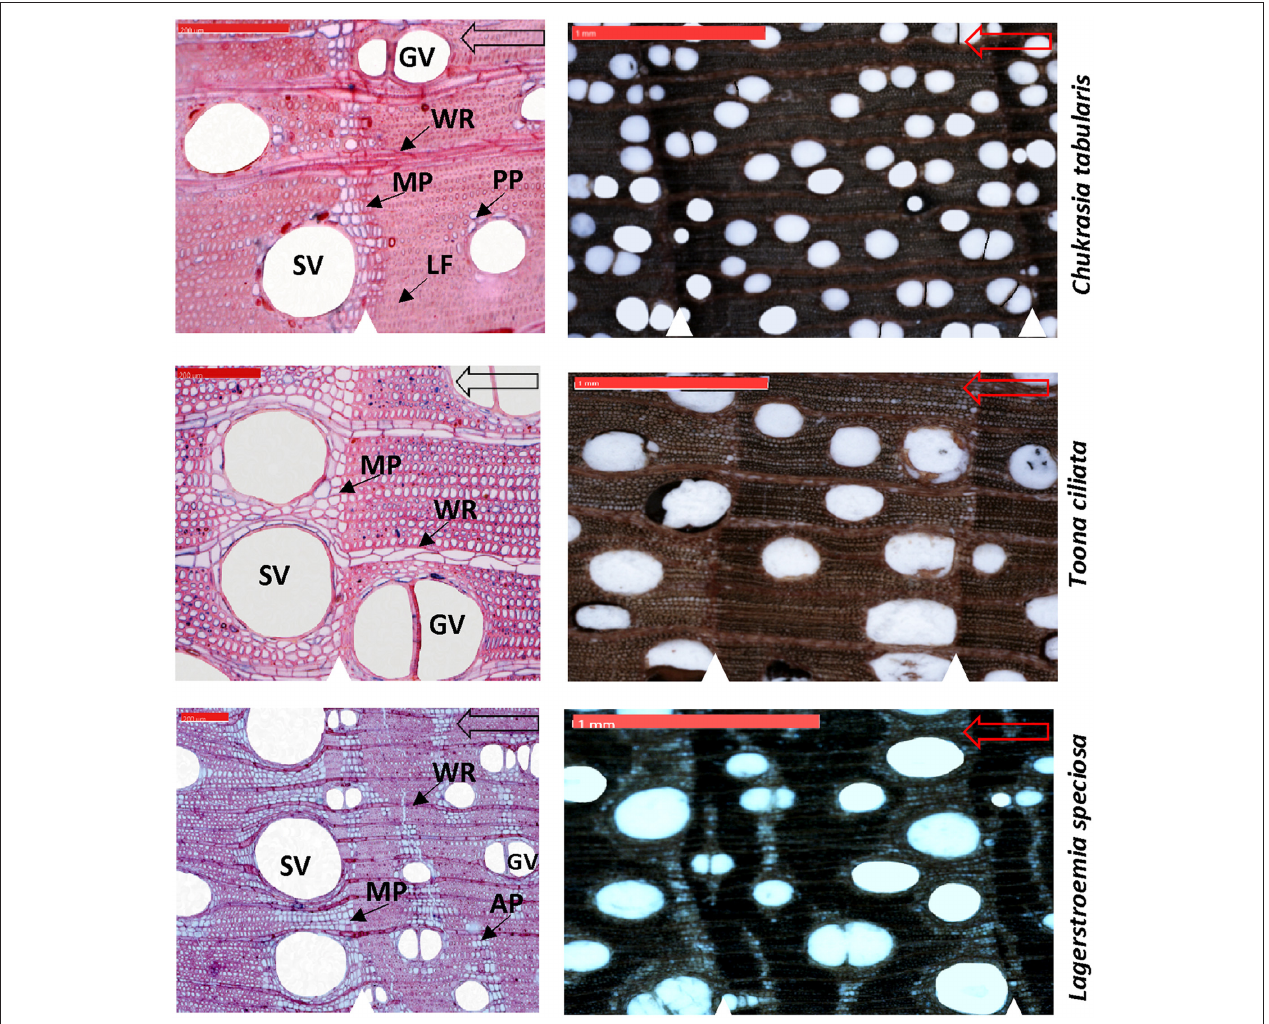
FIGURE 3 | High resolution digital microscopic images of the thin sections ( Left ) and cross sectional wood surface ( Right ) showing characteristic wood anatomical features of three South Asian tropical moist forest tree species. White triangles indicate growth-ring boundaries. Hollow arrows indicate growth direction. SV, solitary vessels; GV, grouped vessels; WR, wood rays; MP, marginal parenchyma; LF, latewood fibers; AP, Apotracheal parenchyma; PP, Paratracheal parenchyma. Scale bars are 200 µ m in the thin sections and 1mm in the cross sectional wood surface